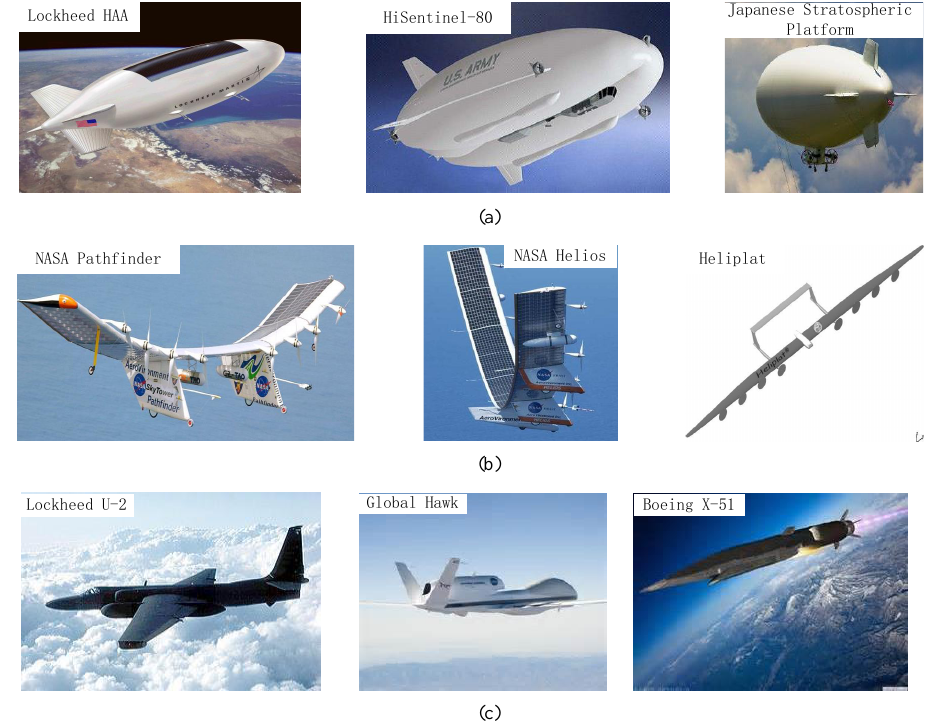
Figure 1. Typical near-space platforms. ( a ) near-space airship (NSA); ( b ) near-space long-endurance low-speed-maneuvering vehicle (NLLV); ( c ) near-space short-endurance high-speed-maneuvering vehicle